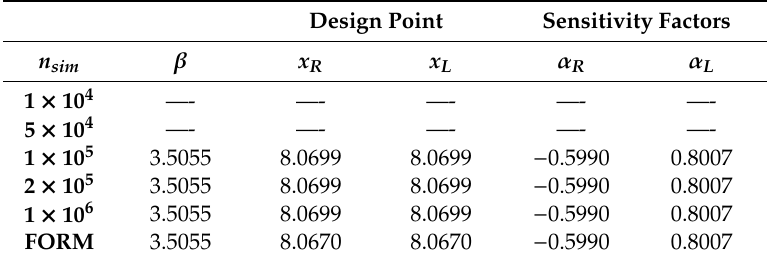
Table2. Designpoint, β and α i byusingmulti-linearregressionandfirstorderreliabilitymethod(FORM). Design